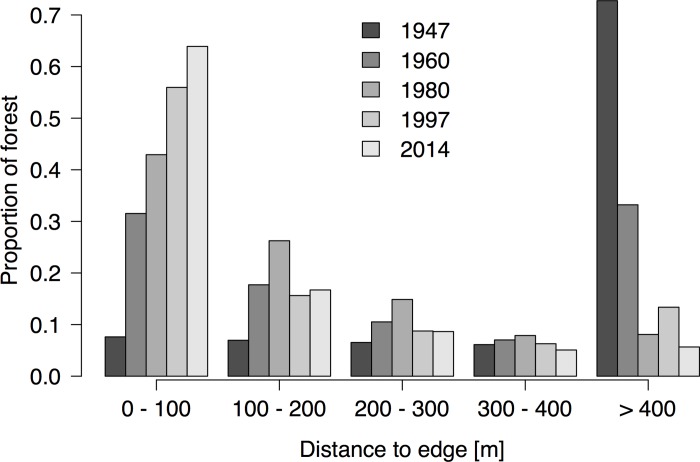
Proportion of forest area remaining grouped by year and distance to nearest forest edge.